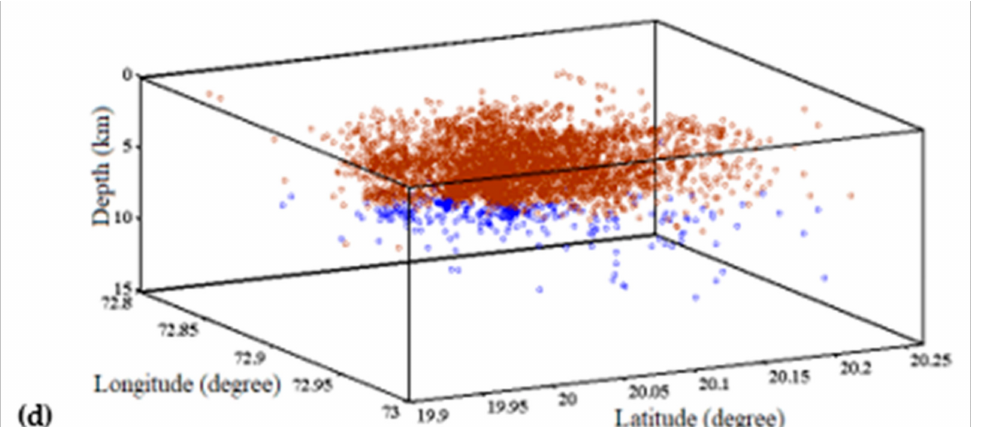
Figure 7. Earthquake 2D depth model and 3D view of earthquake swarms data with spatial variations of earthquakes depth and transects profiles at different sections (horizontal, vertical, and aligned to major fault directions); ( a ) earthquake depth map with the frequency of earthquakes according to depth variations; ( b ) Horizontal transects over grayscale depth image constructed from west to east direction for profile construction; ( c ) Vertical transects constructed over grayscale depth image from North-South direction as lower bottom panel represents VT profiles 1–4, and top-bottom panel represents HT profiles of 1–4, respectively; ( d ) 3D mesh view of earthquakes displaying according to the varied depth of earthquake occurrences in the study area: Dark red open circles represent depth < 5.0 km whilst blue colors show depth > 5.0